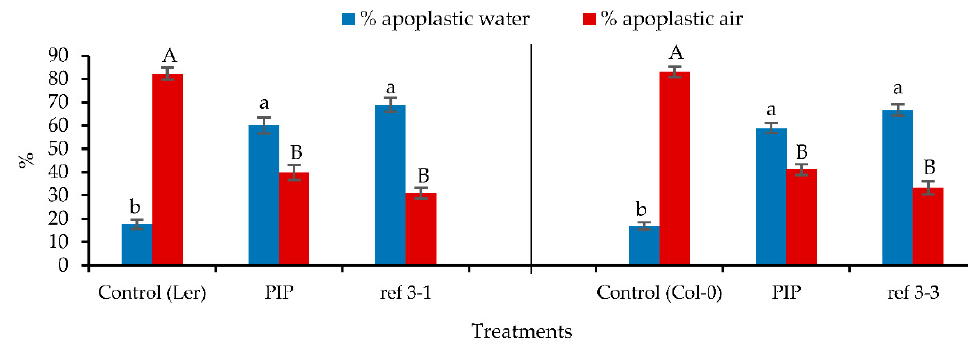
Figure 8. The percentages of apoplastic water and air related to the total volume of the apoplast in Arabidopsis thaliana Ler, Col-0, ref3-1, and ref3-3 seedlings on 0.7% ( w/v ) Micro-agar after 14 days of culture. Different letters indicate significant differences between means at α = 0.05 level. Table 2. Total lignin of Arabidopsis thaliana wild-type, less-lignin-mutant, and wild-type + PIP on Mico-agar medium.